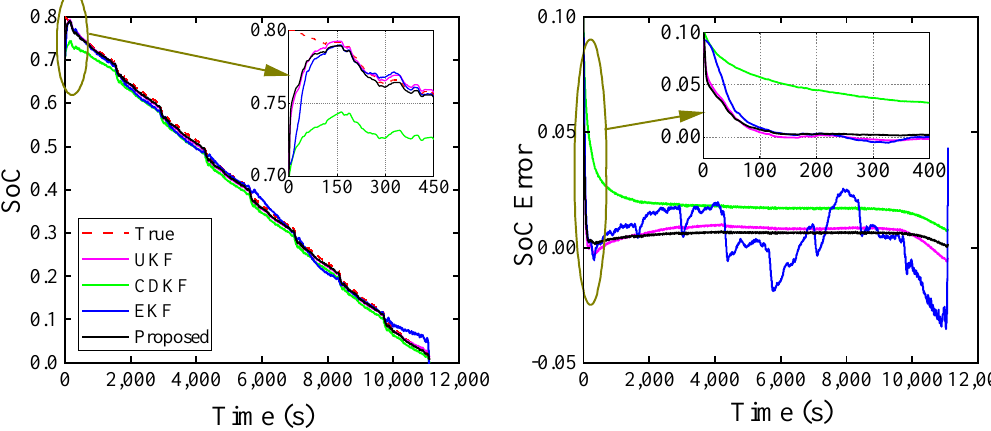
Figure 9. The initial SoC guess was 0.7 under the FUDS condition.